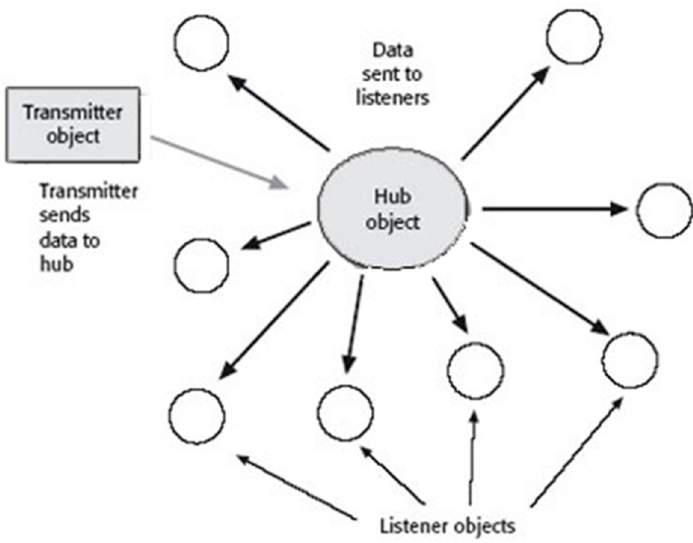
Figure 5. Hub and spoke architecture [104].